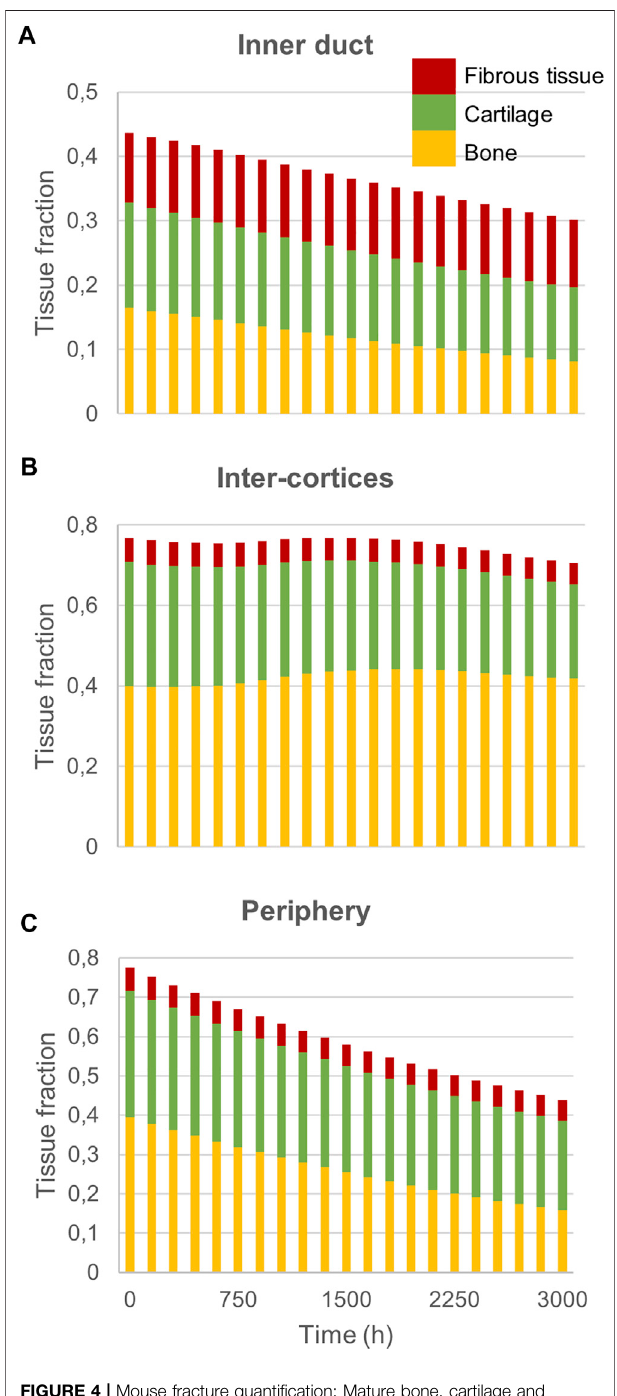
FIGURE 4 | Mouse fracture quanti fi cation: Mature bone, cartilage and fi brous tissue fraction evolution over time in (A) the inner duct; (B) the inter- cortices and (C) the